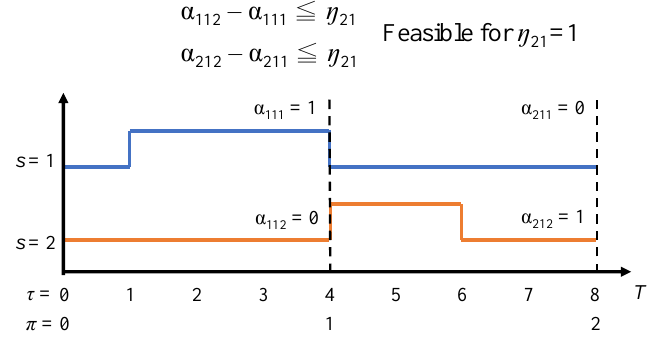
Figure 3. Presentation for task assignment and